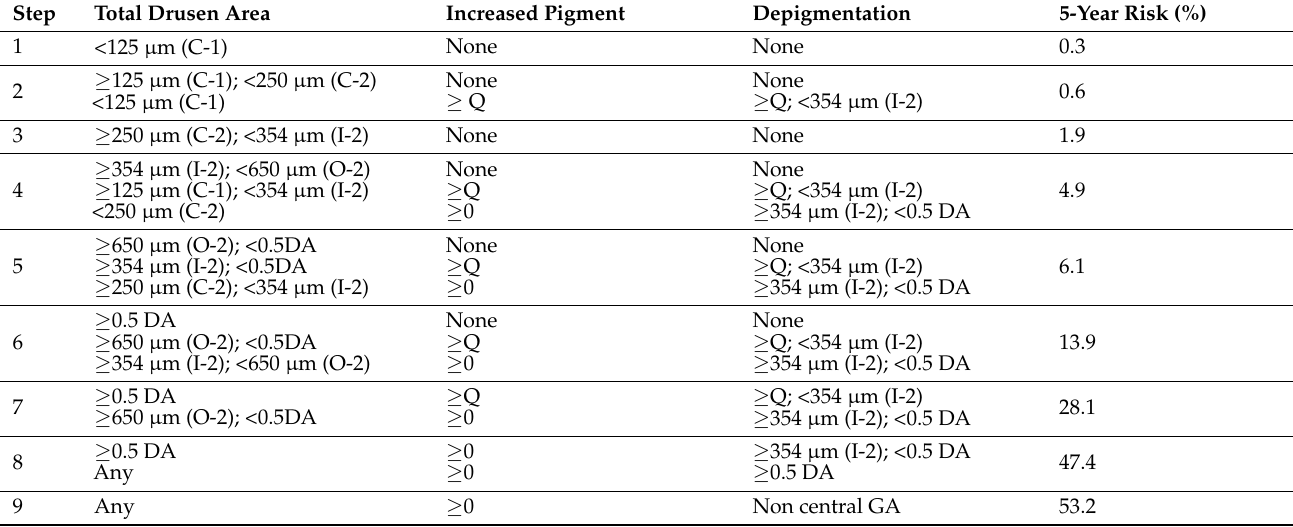
Table 1. The 9-step age-related macular degeneration (AMD) severity scale modified from the AREDS 17